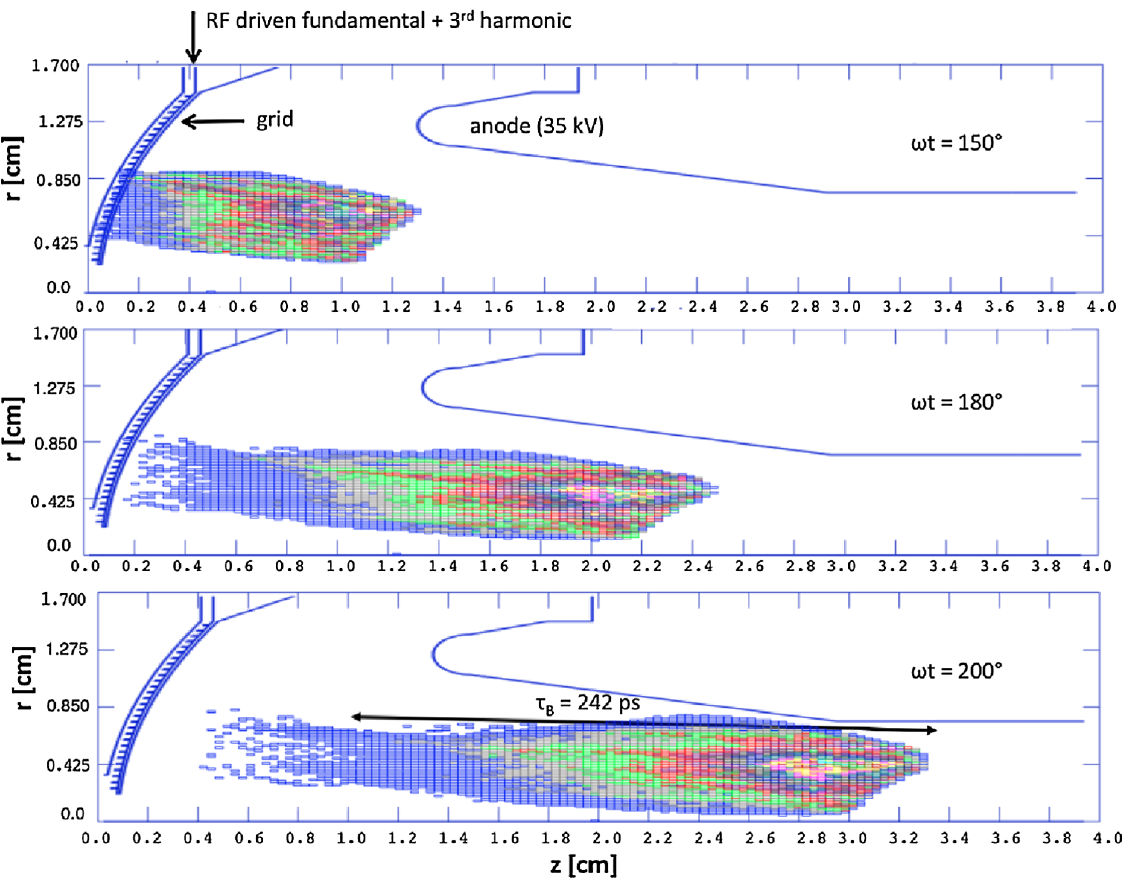
FIG. 17. PARMELA simulation of an rf-gated, gridded thermionic gun. The plots show the generation of a 1 nC electron bunch with end-to-end duration of 242 psec and a normalized emittance of 25 mm mrad. The grid is biased to (cid:3) 450 V dc, and the anode is biased to 35 kV relative to the cathode. The amplitude of the rf field in the cathode-grid gap is 9 : 4 kV = cm . The rf phase !t is indicated in each figure.